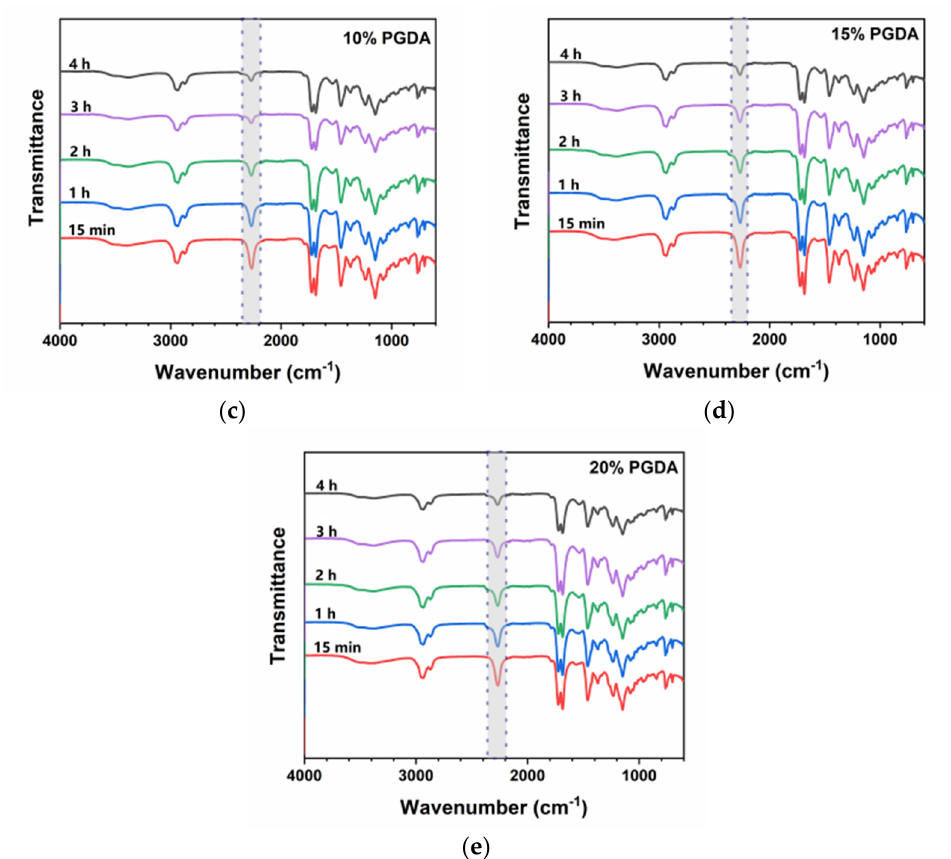
Figure 2. Progress of the curing reaction by FTIR spectroscopy ( a ) 0% PGDA; ( b ) 5% PGDA; ( c ) 10% PGDA; ( d ) 15% PGDA; ( e ) 20% PGDA.